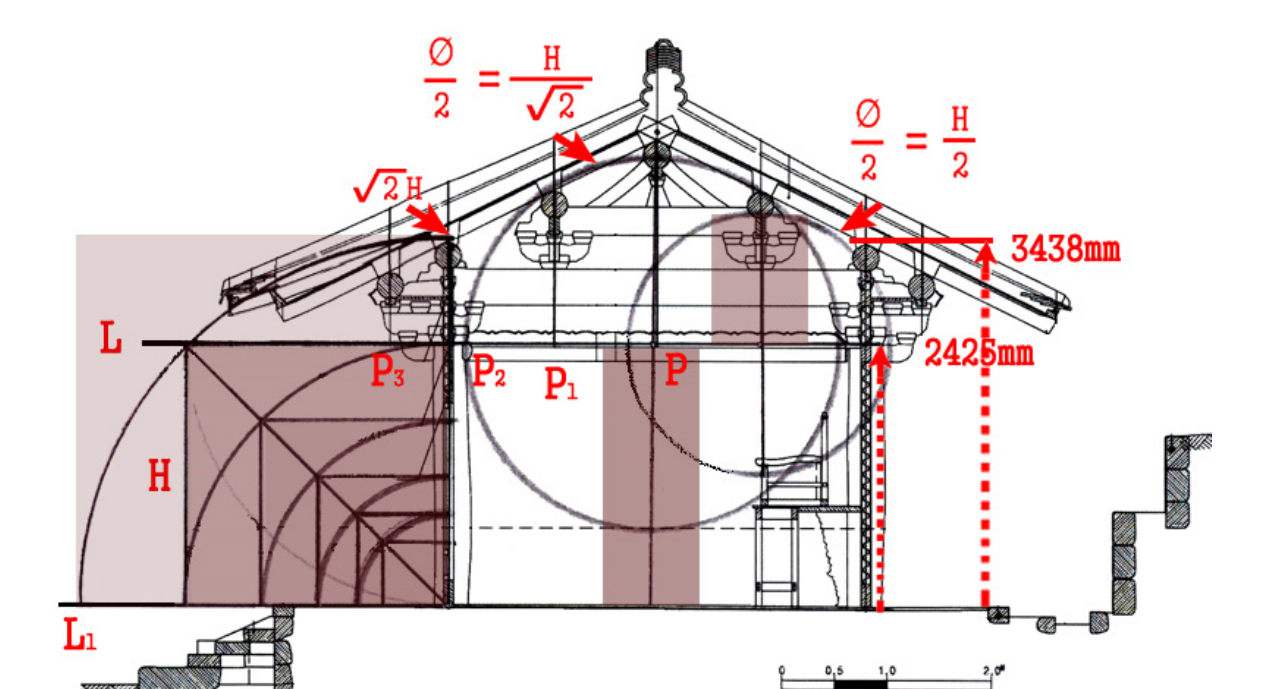
Figure 14. Josadang Hall of Buseoksa Monastery. Proportional analysis of the sectional elevation (H = eave column height, Ø = circle diameter), Adapted from CHA (2005b, p. 274).